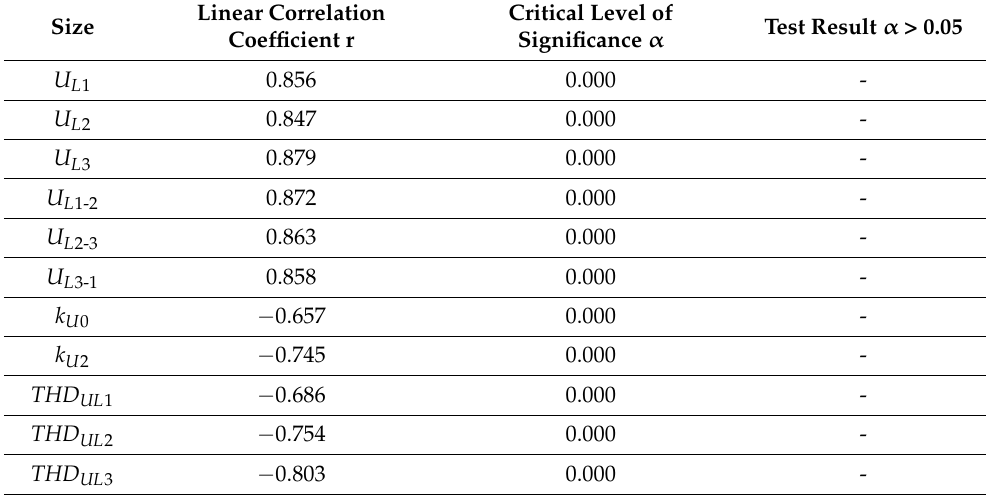
Table 5. Results of the statistical analysis of the dependence of individual power quality indicators on the three-phase power ( P III ) of the power plant under